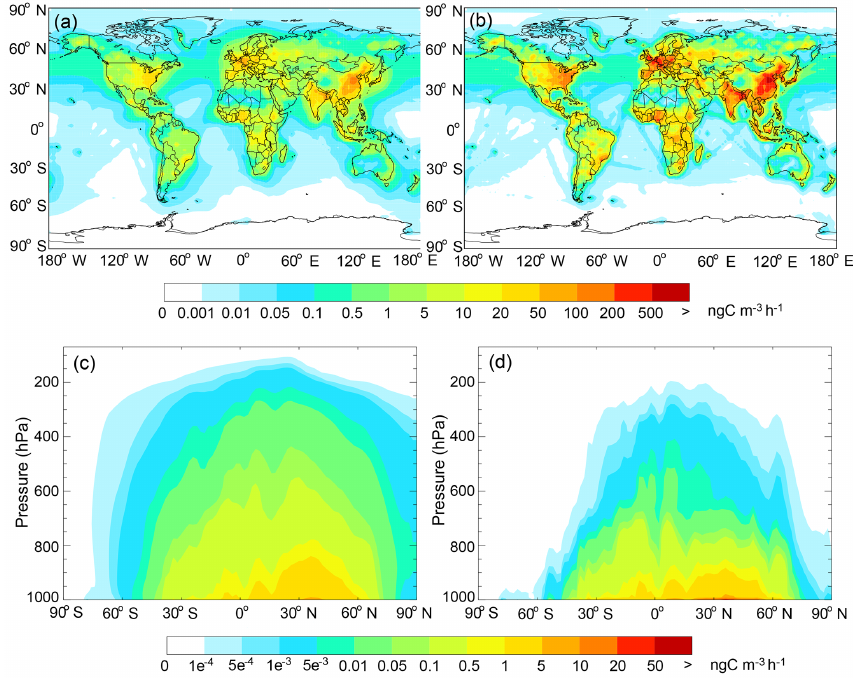
Figure 2. GEOS-Chem simulated annual mean BC aging rates (ngCm − 3 h − 1 ) in the surface layer (top panels) and averaged zonally (lower panels) from a fixed BC aging scheme (left panels) and a microphysics-based aging scheme (right panels). See text for details. Model results are for